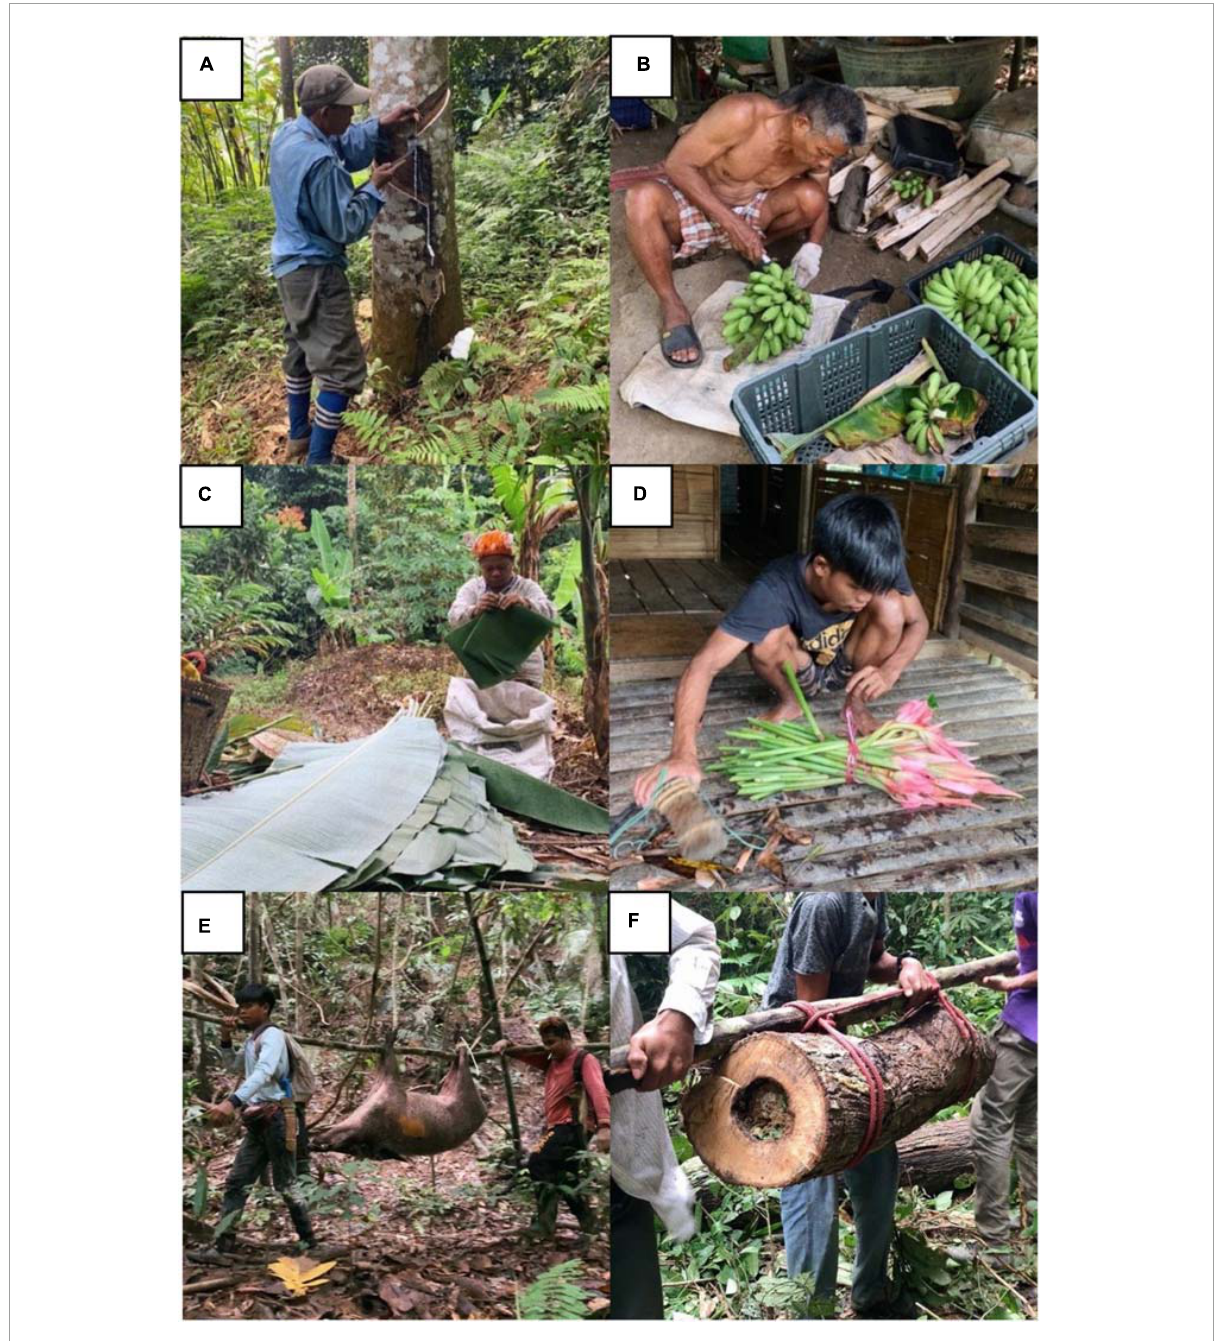
FIGURE4 Some of the kerja kampung in Tanjung Rambai include rubber tapping (A) , banana cultivation (B) , collecting banana leaves (C) and bunga kantan (D) , snaring wild game (E) , and collecting stingless bee honey (F) . Source: Photographed by the first author in Hulu Langat, Selangor, Malaysia (A–D,F) , and Gelami Lemi, Negeri Sembilan, Malaysia (E) , in November 2021.